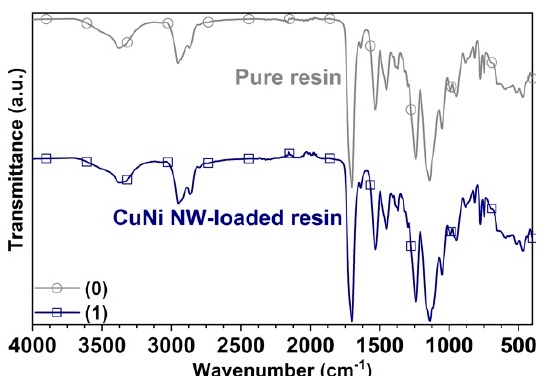
Figure 9. FTIR spectra acquired on the substrates printed with (0) pure resin and (1) CuNi NW-loaded resin.